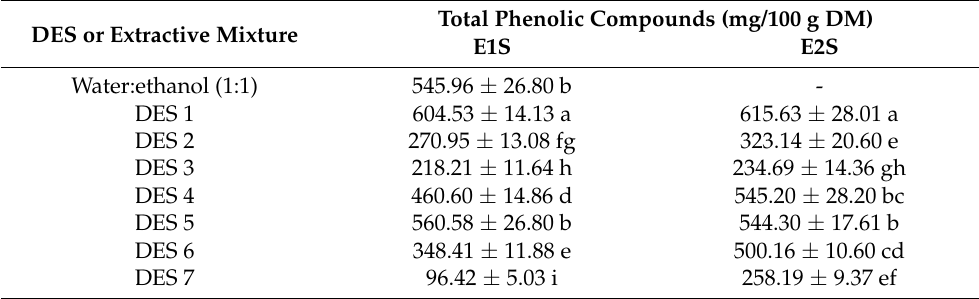
Table 6. Total phenolic compounds (TPC) for extraction supplemented with pectinlyase-Group 2. DES or Extractive